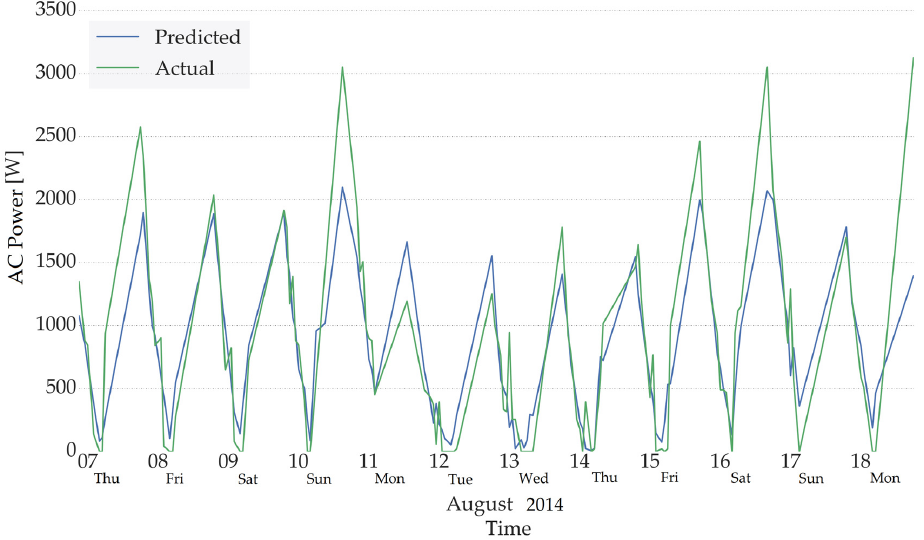
Figure 6. Hour-ahead predictions using Random Forest Decision Tree.